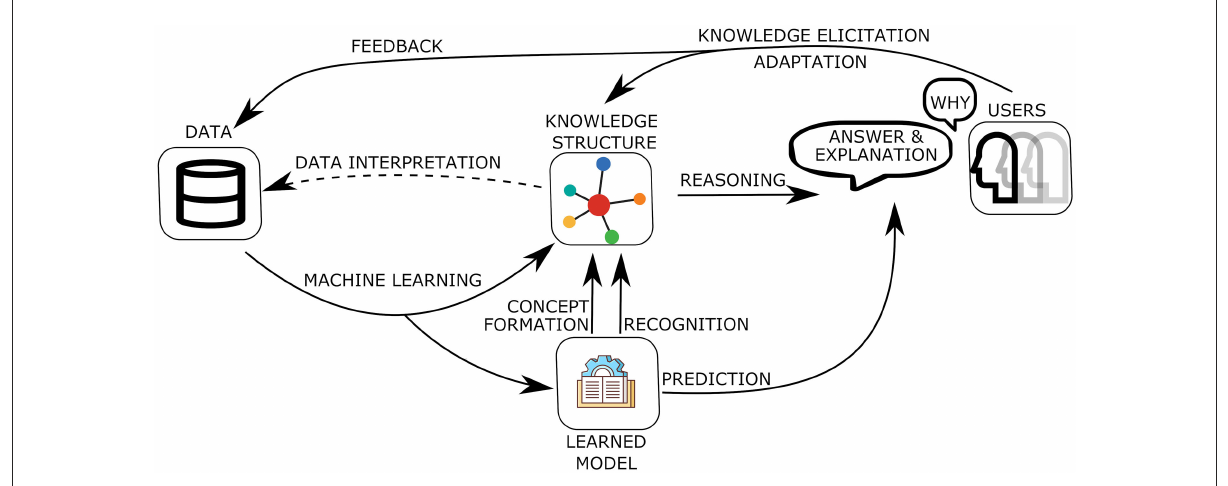
FIGURE1 A high-level architecture of AI